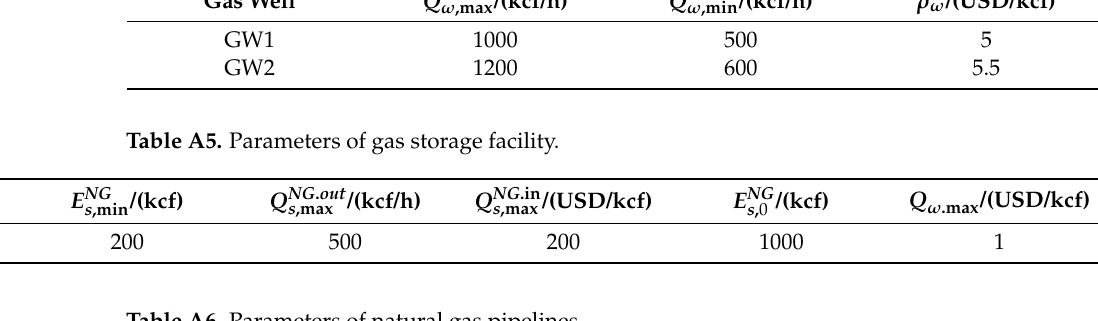
Table A6. Parameters of natural gas pipelines.